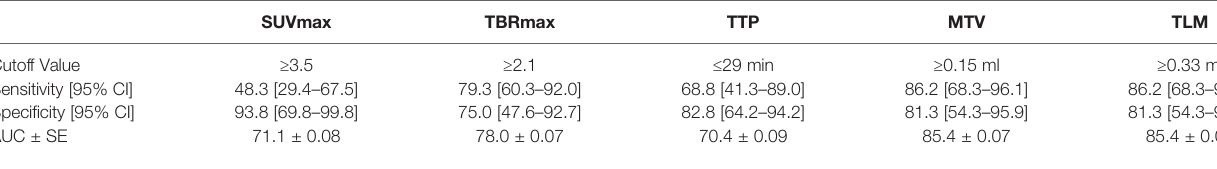
TABLE 3 | GR diagnostic performance of static and dynamic 18 F-FET PET